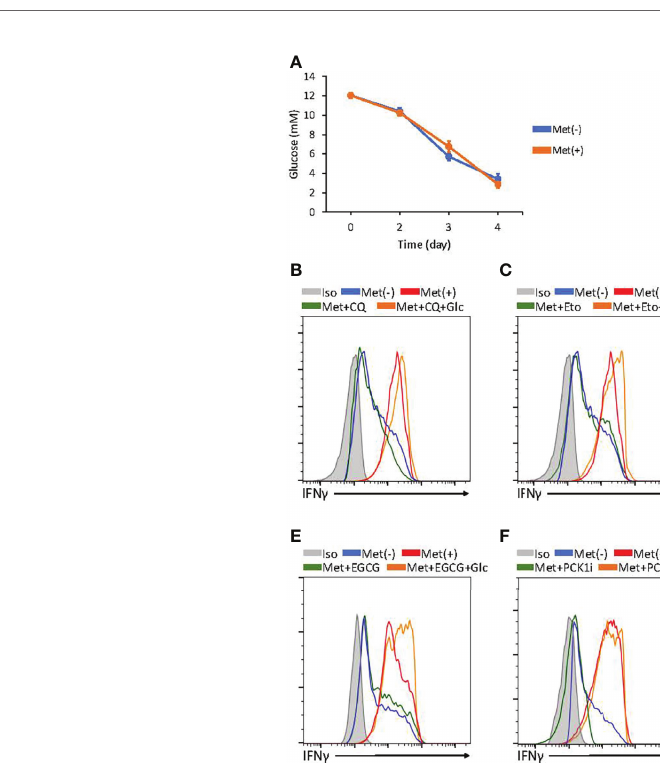
FIGURE 6 | Glucose concentration determines metabolism required for IFN g production by in vitro activated CD8 + T cells. (A) The graphs represent the glucose concentrations in the supernatant of CD8 + T cell cultured with or without Met. (B – F) In vitro activated CD8 + T cells at 72h were further incubated with or without supplementation of glucose for additional 24h and the resulting cells were treated with PMA and ionomycin in the presence or absence of inhibitors, as indicated in CQ (B) , Etomoxir (C) , BPTES (D) , epigallocatechin gallate (EGCG) (E) , and 3MPA(PCL1i) (F) . A representative fl ow cytometry plot showing the in vitro IFN g levels in the CD8 + T cells at 96h. The graphs represent the mean ±